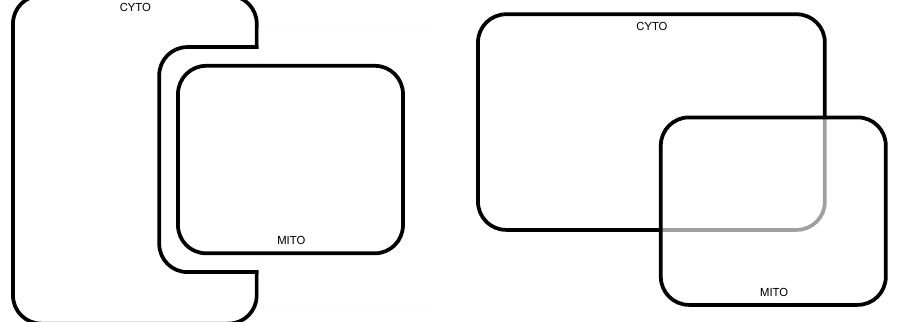
Figure 2.20: Overlapped compartments are permitted, but the overlap does not imply con- tainment.